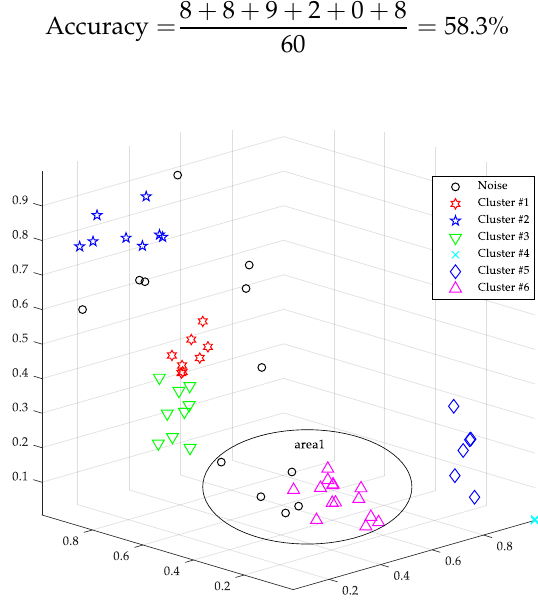
Table 2. Fault aggregation coefficient of data multiplied by coefficient.